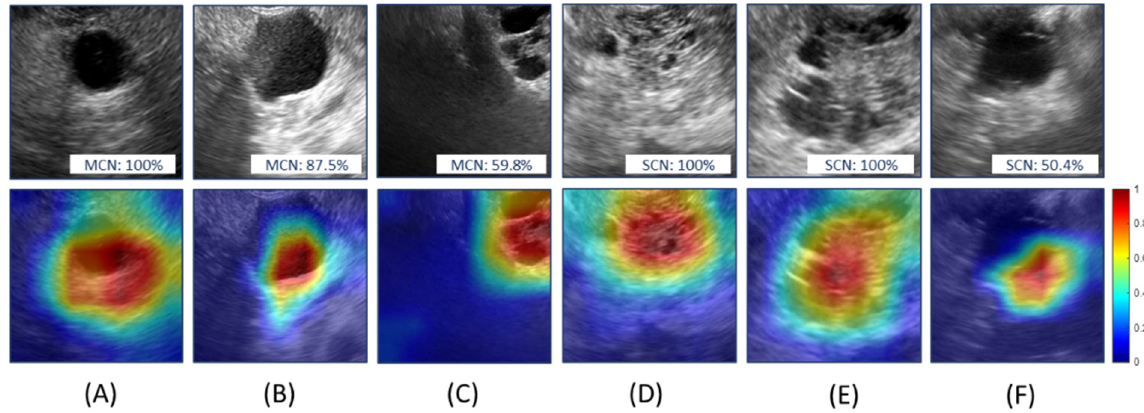
Figure 9. Grad-CAM mapping obtained using ResNet-Conv+FC. The upper row shows the selected ROIs from test images and the lower row shows the corresponding Grad-CAM mappings. ( A – C ): mucinous cystic neoplasm and ( D – F ): serous